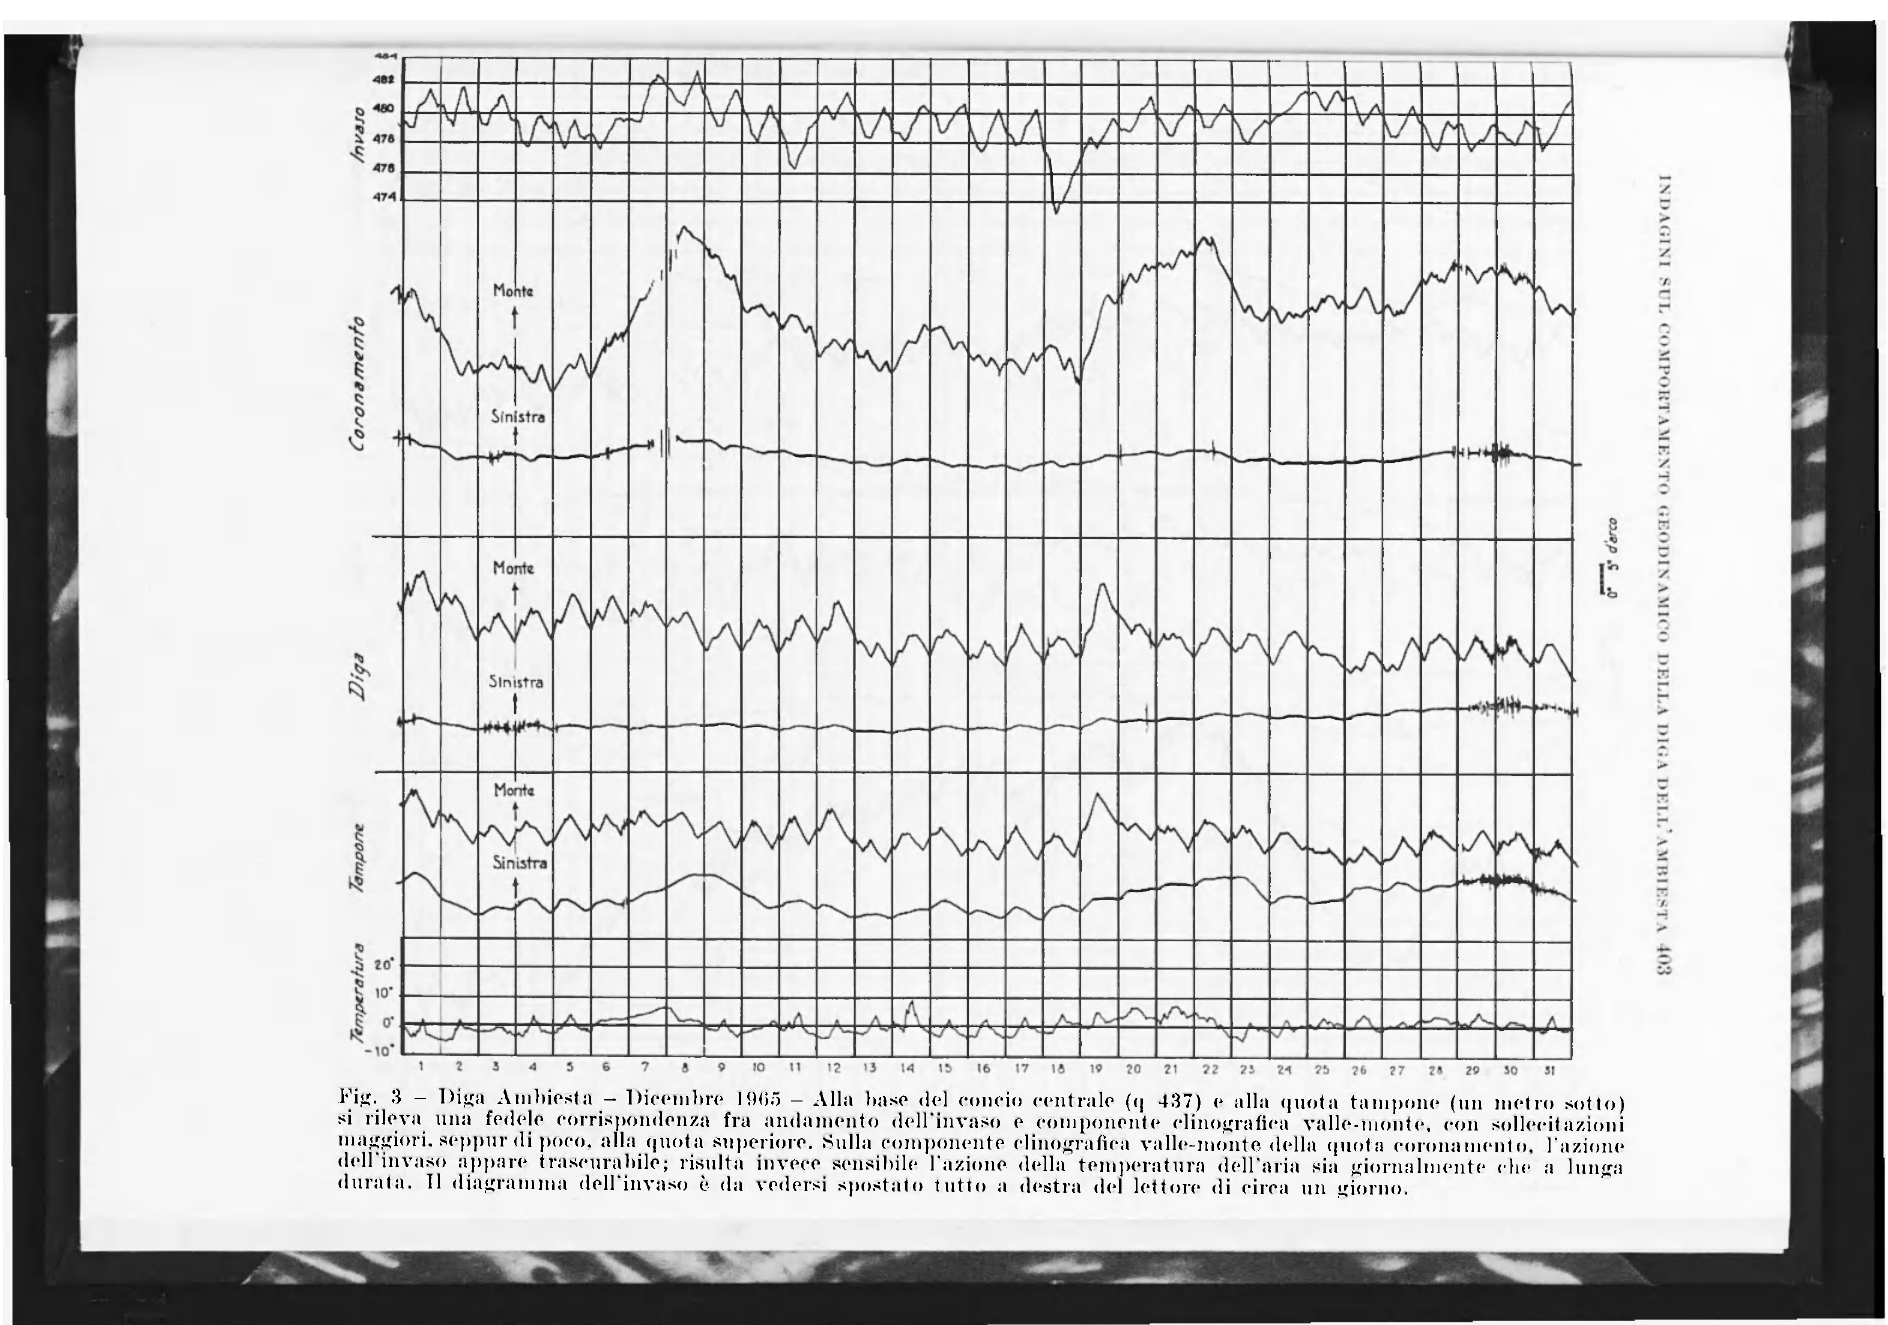
Fig. 3 - Diga Ambiesta - Dicembre 19G5 - Alla base del concio centrale (q 437) e alla quota tampone (un metro sotto) si rileva una fedele corrispondenza fra andamento dell'invaso e componente clinografica valle-monte, con sollecitazioni maggiori, seppur di poco, alla quota superiore. Sulla componente clinografica valle-monte della quota coronamento, l'azione dell'invaso appare trascurabile; risulta invece sensibile l'azione della temperatura dell'aria sia giornalmente che a lunga durata. Il diagramma dell'invaso è da vedersi spostato tutto a destra del lettore di circa un